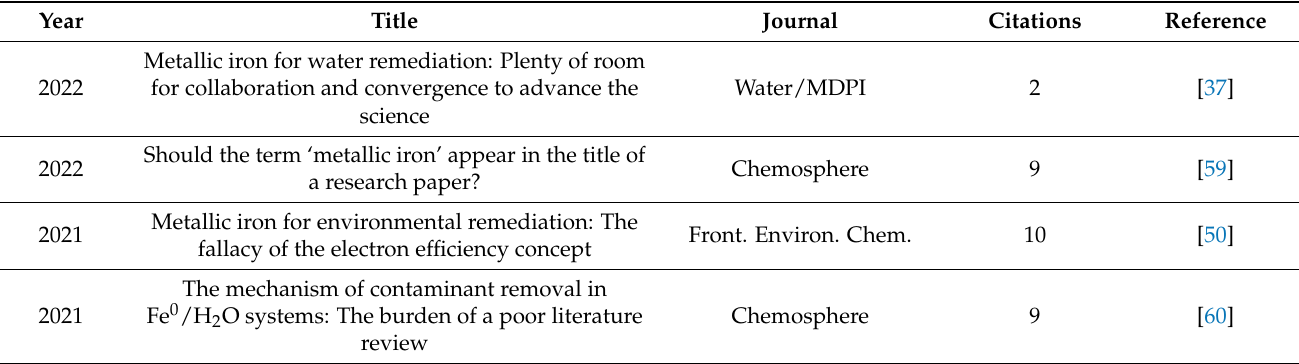
Table 2. A selection of 34 articles of our research group refuting the view that Fe 0 oxidative dissolution is the anodic half-reaction coupled to contaminant reduction in Fe 0 /H 2 O systems. Citations stands for the number of references according to Google Scholar (Accessed on 31 August